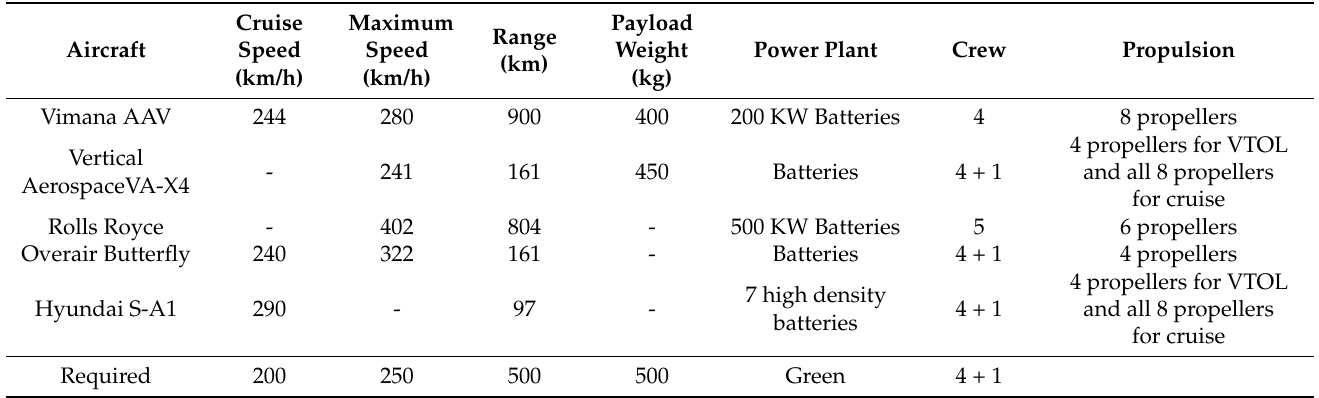
Table 1. A list of similar and relevant eVTOLs